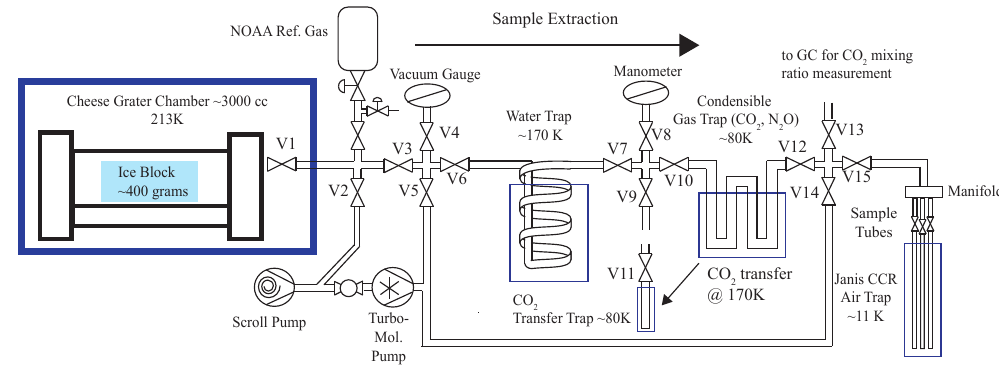
Figure 1. Extraction line: a simplified schematic of the ice core air extraction vacuum line.